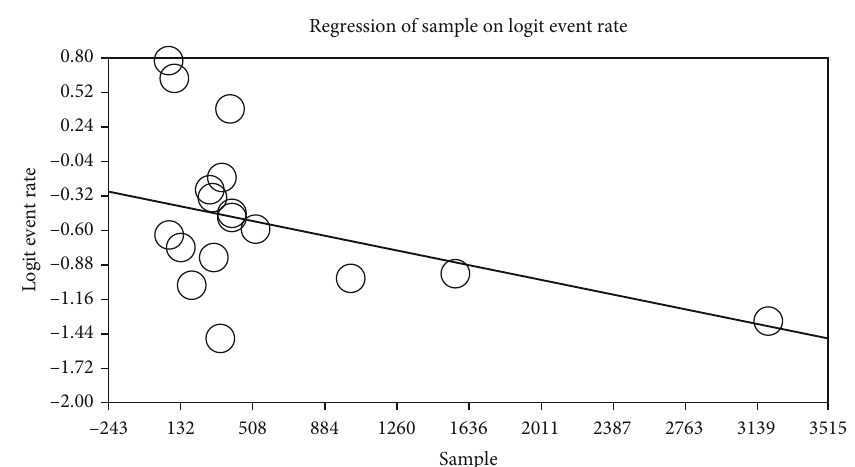
Figure 5: Metaregression of the relationship between the sample size and prevalence of cardiovascular disease in patients with type 2 diabetes mellitus (DM) in